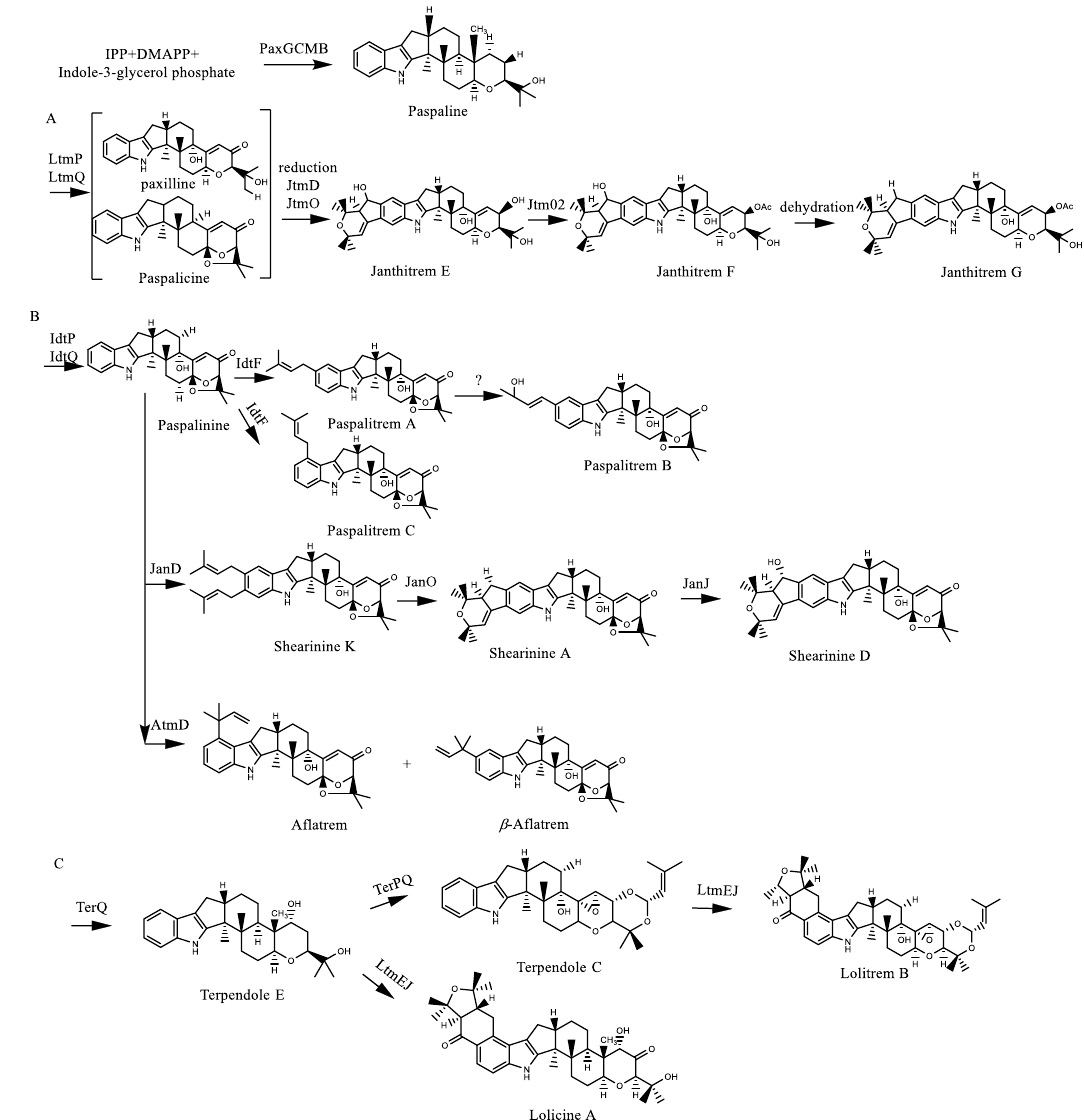
Figure 1. Biosynthetic pathways for classical paspaline-derived indole diterpenes (the initials stand for related enzymes). ( A ) The synthesis pathway of Janthitrem analogues in response to the corre- sponding Jtm enzyme. ( B ) The synthesis pathway of Paspalitrem, Shearinine and Flatrem analogues in response to the corresponding Idt, Jan and Atm enzymes. ( C ) The synthesis pathway of Terpendole, Lolicine and Lolitrem analogues in response to the corresponding Ter and Ltm